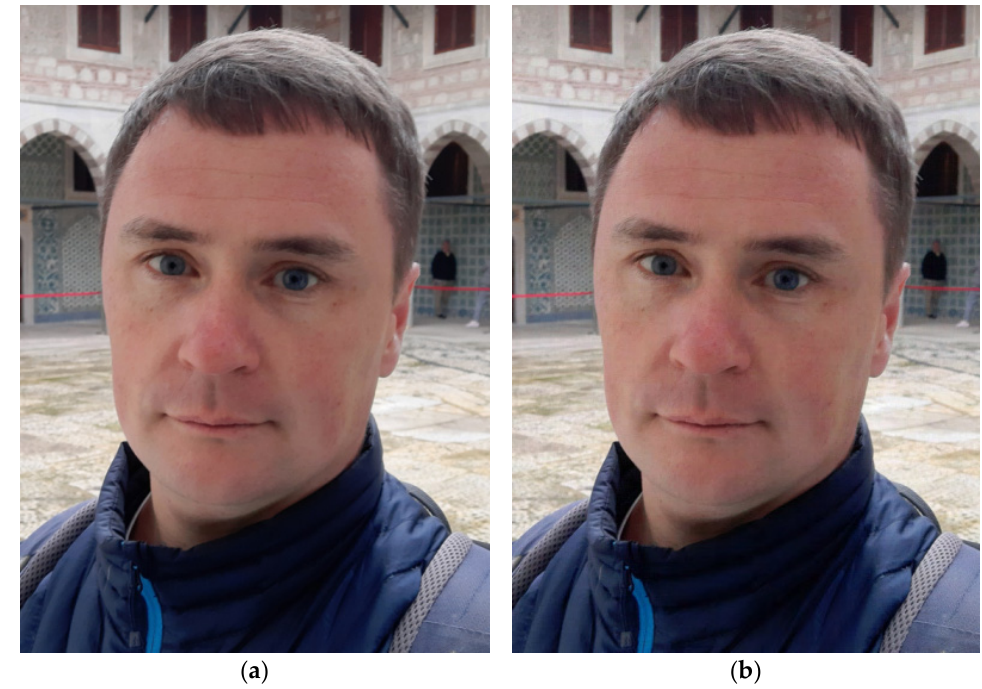
Figure 11. A 24-bit full-color digital image, 544 × 393, 626 KB (BMP): original ( a ); reconstructed after lossy compression using DAC with DAT1 of the depth 5 (UBMAD = 95) ( b ).